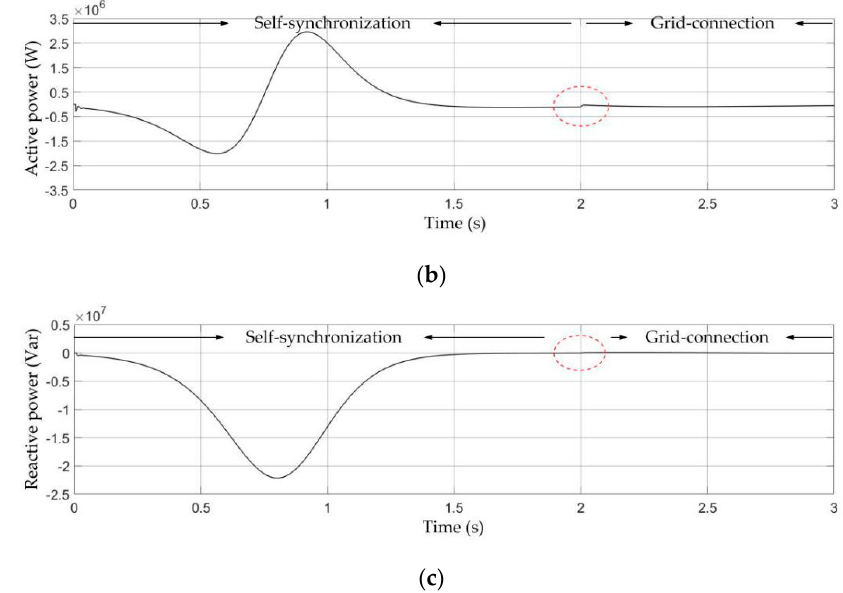
Figure 13. The output frequency, output active power and output reactive power of the system in islanded mode and grid-connected mode: ( a ) output frequency f ; ( b ) output active power P ; and ( c ) output reactive power Q .